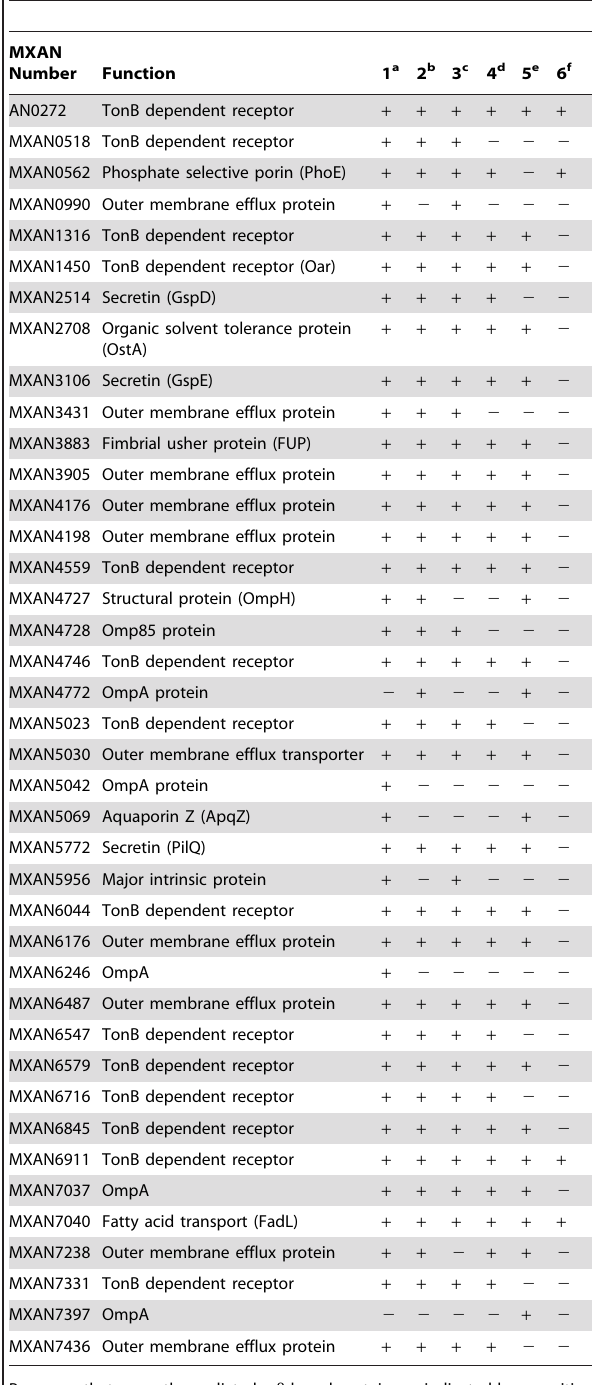
Table 1. M. xanthus b -barrel domain proteins obtained from the Pfam